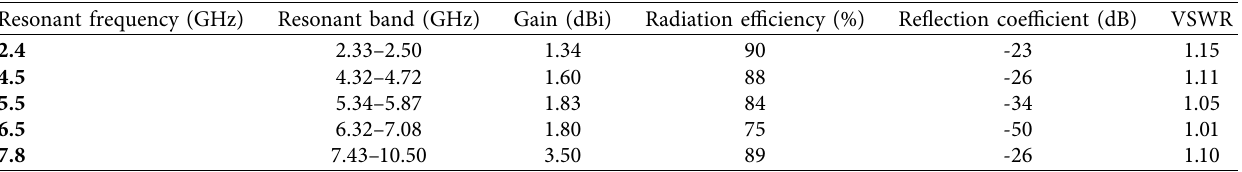
Table 4: Summary of various performance parameters.